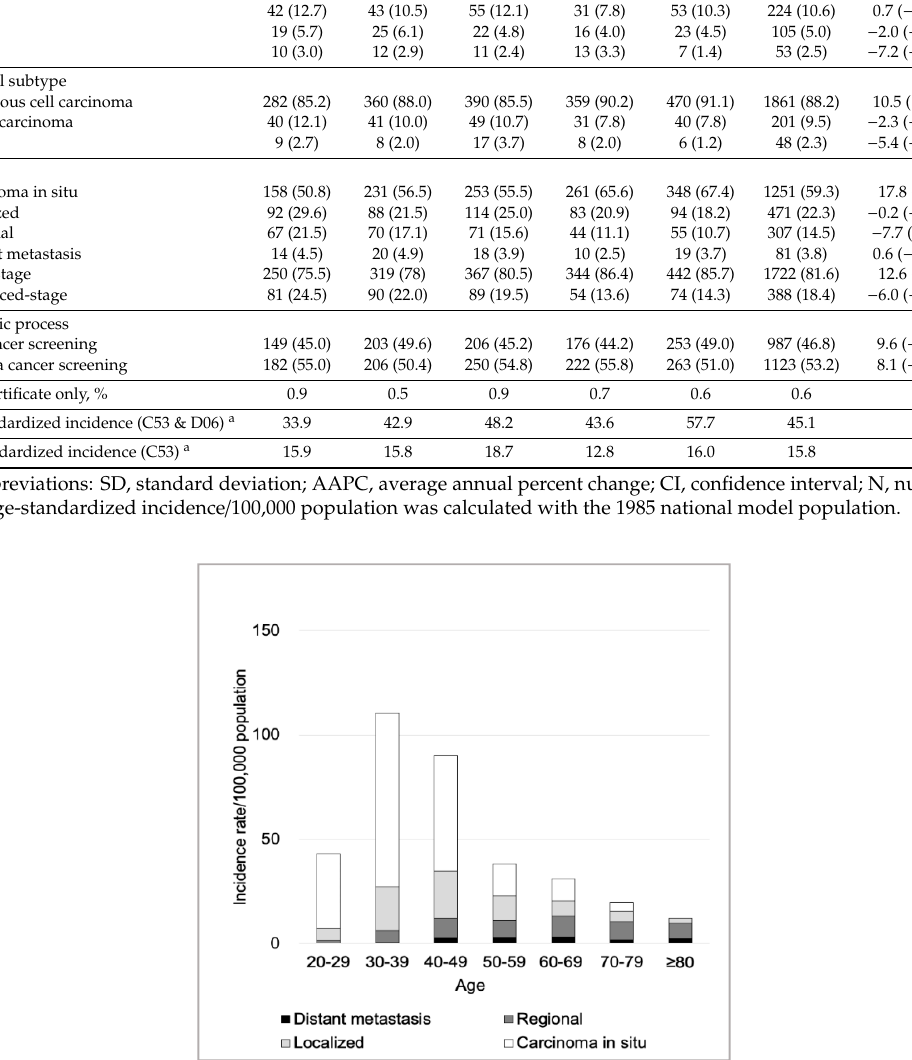
Figure 2. Age-specific average annual percent change for cervical cancer stratified by histological subtype. The average annual percent change (dot) and 95% confidence intervals (line) were estimated using joinpoint regression analyses. Upper panels indicate data of overall cervical cancer patients, including those with carcinoma in situ (ICD-10, D06) and invasive cancer (C53). Lower panels indicate data of those with only invasive cervical cancer (C53). In the additional analyses stratified by cancer stage and diagnostic process, the incidence of early-stage cancer through the non-cancer screening processes, particularly that specific to the SCC subtype among younger women, showed a significant increase (Table 3). In the subgroup analysis limited to invasive cervical cancer (C53 in ICD-10), the overall age- standardized incidence was 15.8/100,000 population (Table 1). The age-specific incidence stratified by histology showed a similar pattern (Figure 2 and Table 2).